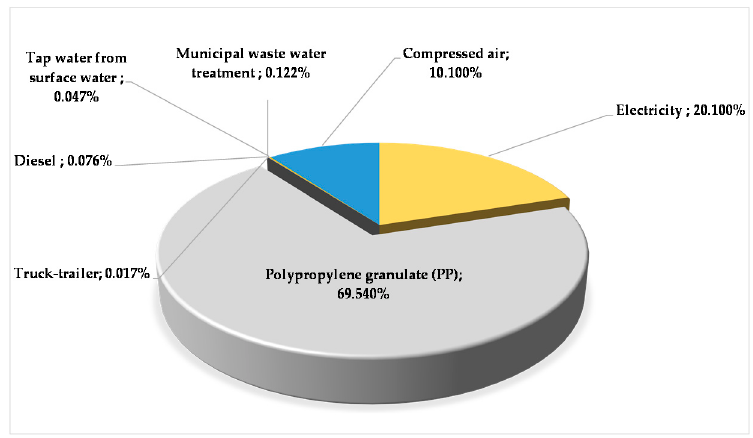
Figure 3. Relative contribution percentage of input ‒ output materials and energy flows in the production stage. Table 1. The examined environmental impact categories [28,33].